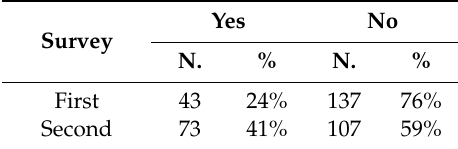
Table 7. Willingness to purchase (N. 180).